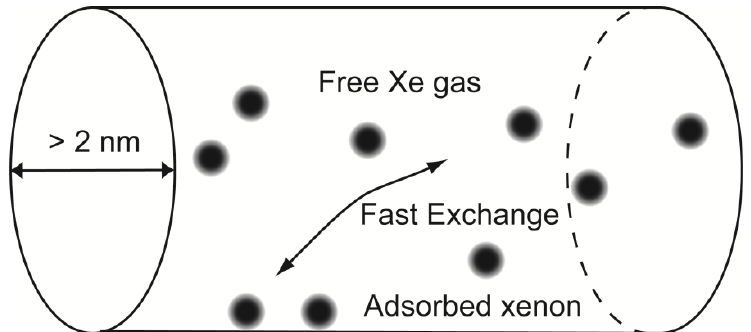
Figure 1. Model of interaction between gaseous xenon and an idealized cylindrical